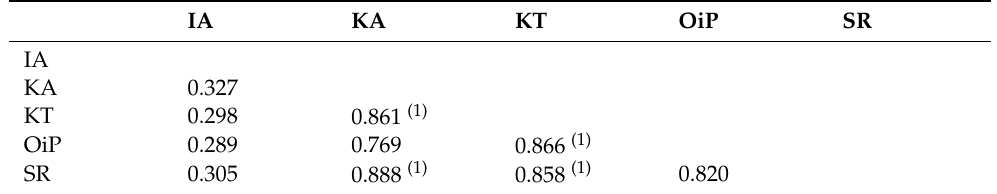
Table 5. Assessment of discriminant validity of the path model in phase two using the HTMT